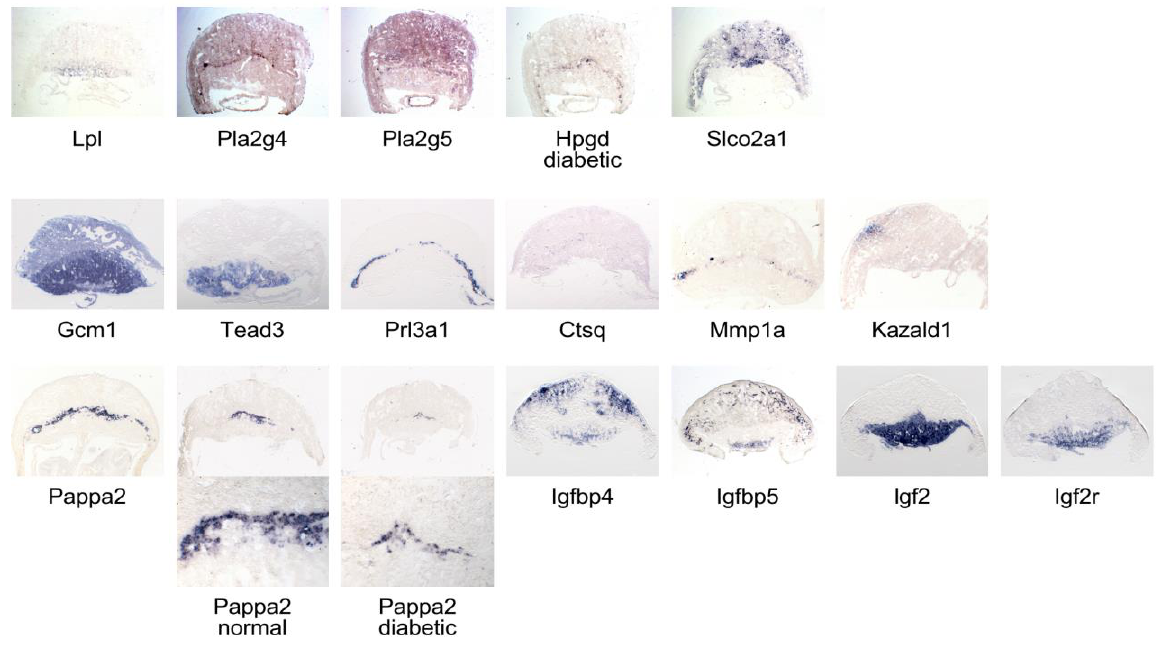
Figure 6. In situ hybridization reveals region- and cell-type-specific gene expression in normal and diabetic placentae. Sections were produced from OCT-embedded frozen tissue from normoglycemic dams, except where indicated that the sample came from a diabetic female.